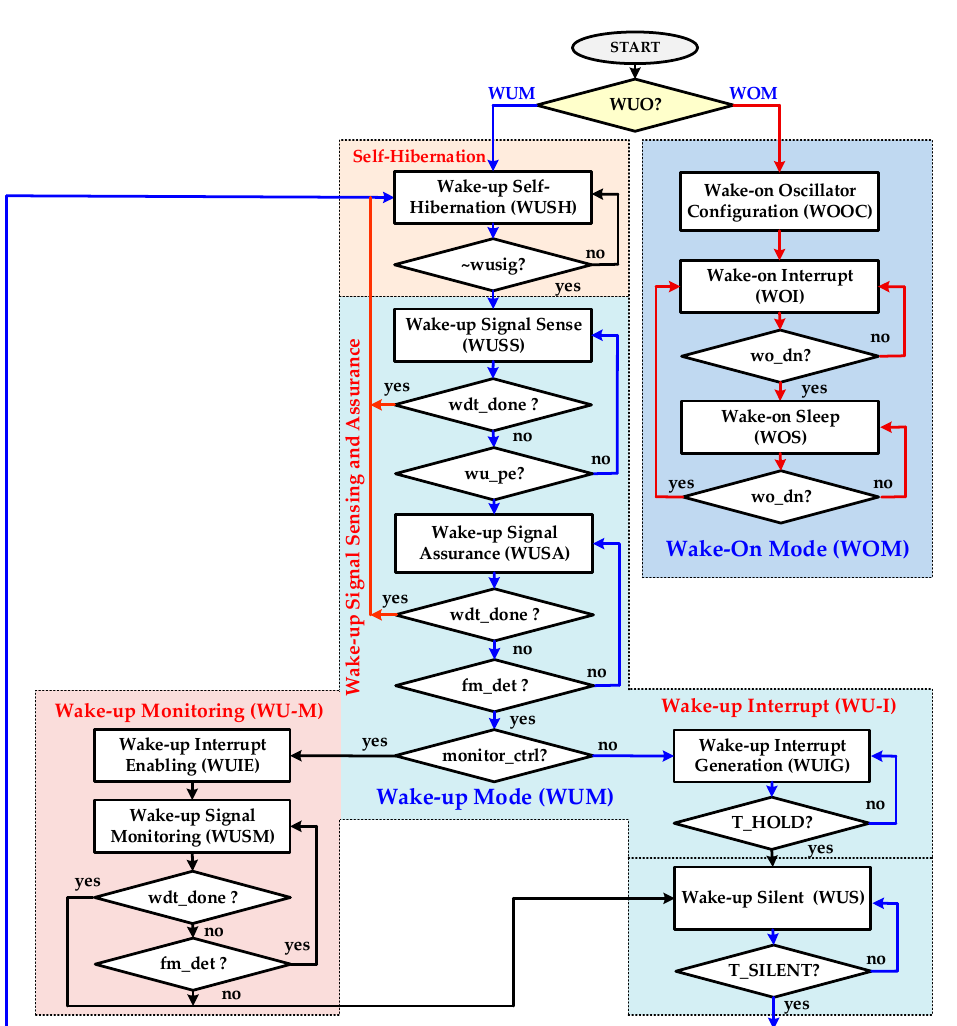
Figure 8. WuRx intelligent digital controller (IDC) finite state machine controller (FSMC) flow diagram.